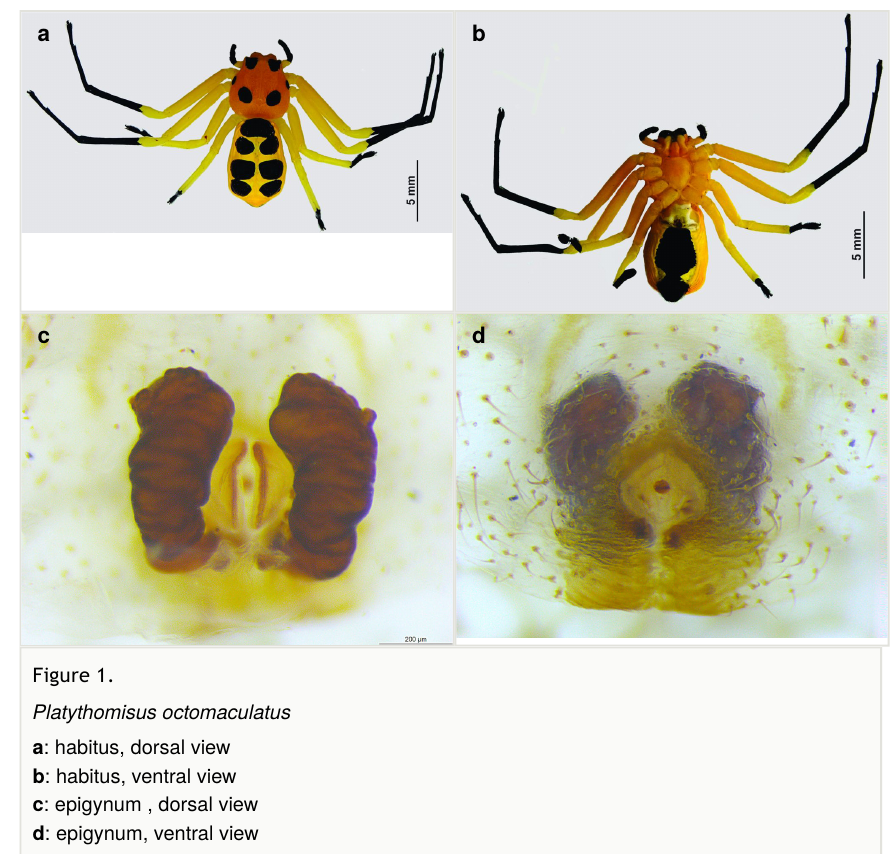
Figure 1. Platythomisus